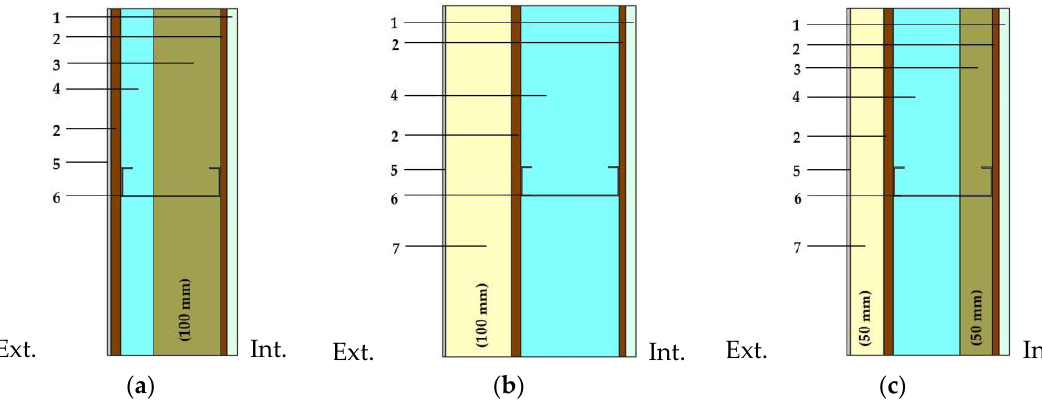
Figure 1. Classification of LSF constructions, depending on the position of the thermal insulation: ( a ) cold frame construction; ( b ) warm frame construction; ( c ) hybrid frame construction. Materials: 1—Gypsum board; 2—OSB; 3—RW; 4—Air; 5—ETICS finish; 6—LSF; 7—EPS.